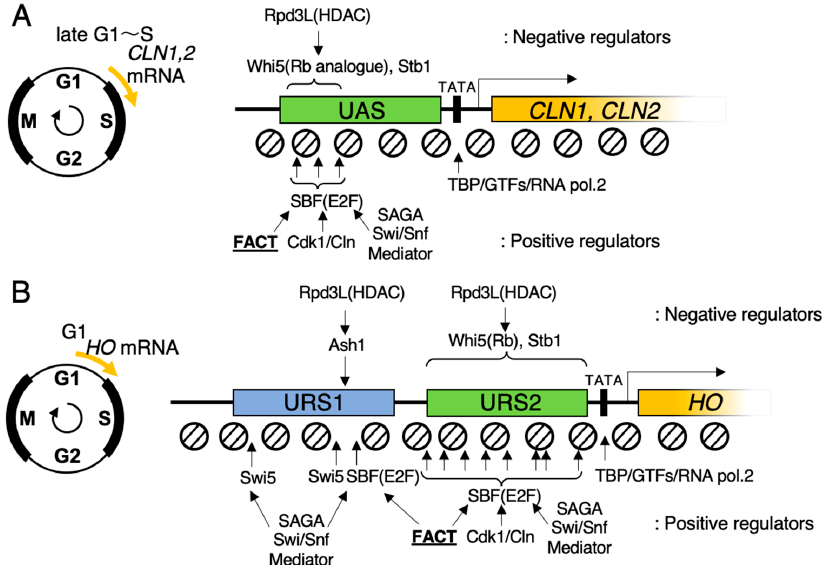
Figure 3. Schematic diagrams of SBF-regulated gene promoter. UAS: upstream activating sequence, URS1: upstream regulatory sequence 1, URS2: upstream regulatory sequence 2. ( A ) Promoter structure of CLN1 and CLN2 genes. Three SBF-binding sites are annotated as arrows. Positive and negative regulators of gene expression are shown below and above the schematic of the gene structure, respectively. FACT is assigned an underline. ( B ) Promoter structure of the HO gene. Two Swi5-binding sites, one SBF-binding site, and one Ash1-binding site are annotated in URS1. Eight SBF-binding sites are annotated in URS2. Positive and negative regulators of gene expression are shown below and above the schematic of the gene structure, respectively. FACT is assigned an underline.